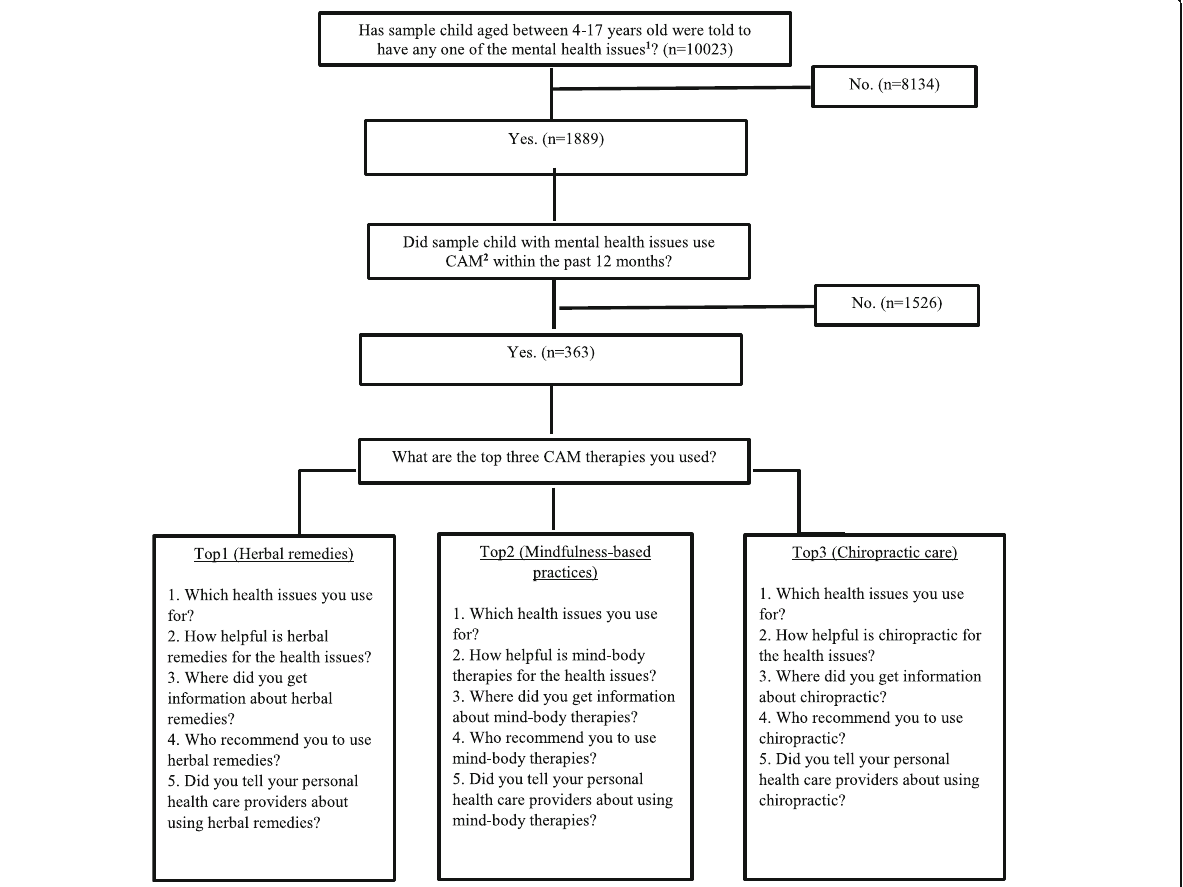
Fig. 1 Flow Chart of CAM use among children with mental health issues: 2012